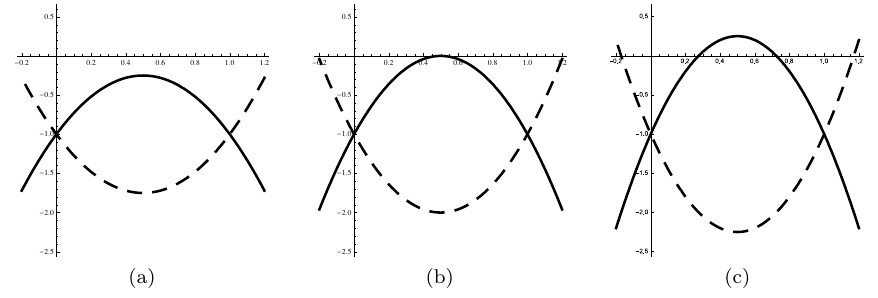
Figure 5. Roots of characteristic equation (3.8), thick line for − 1 + µx (1 − x ) , dashed line for − 1 − µx (1 − x ) , for a) µ ∈ (0;4) , b) µ = 4 and c) µ ∈ (4; ∞ )